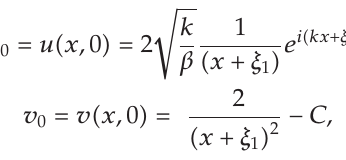
(cid:7) 2, and ξ (cid:7) 0 1